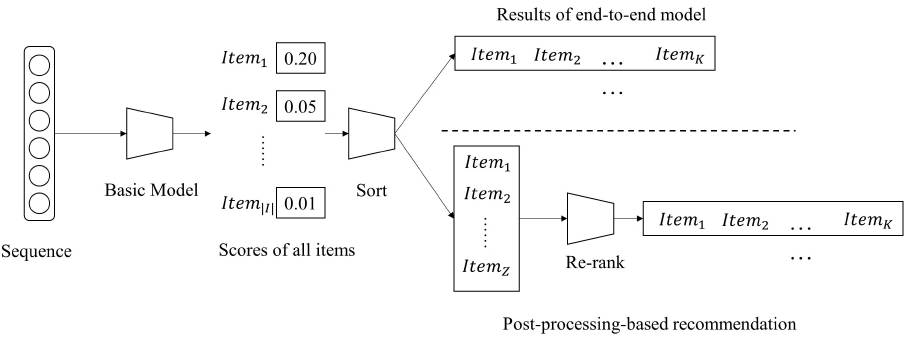
Figure 1. An illustration of end-to-end and post-processing-based